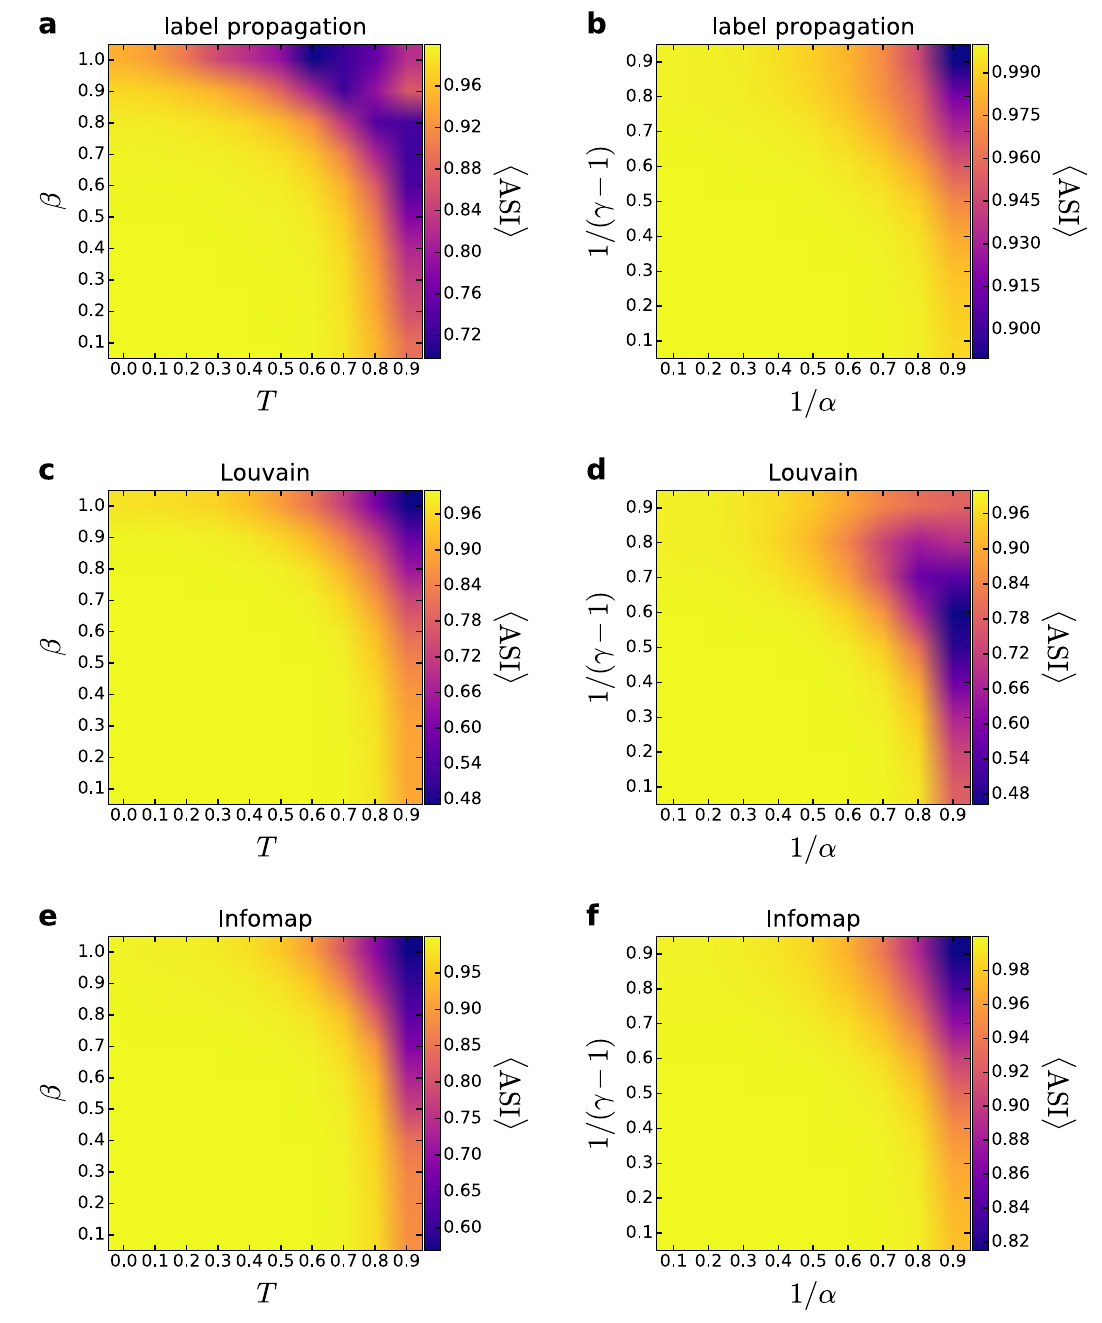
Figure 2. Angular separation index in the PSO and the S 1 / H 2 models. The results for the PSO model are given in the left column ( a , c , e ), whereas the ASI obtained for the S 1 / H 2 model appears in the right column ( b , d , f ). The ASI for the communities detected by asynchronous label propagation is given in the top row ( a , b ), the ASI regarding the results of Louvain is shown in the middle row ( c , d ) and the ASI for the partitions found by Infomap is presented in the bottom row ( e , f ). We show the measured ASI (indicated by the color, averaged 1 ) for networks of size over 100 samples) as a function of the model parameters T and β , or 1 /α and 1 /(γ − N k 10,000 and expected average degree 10 = � � =